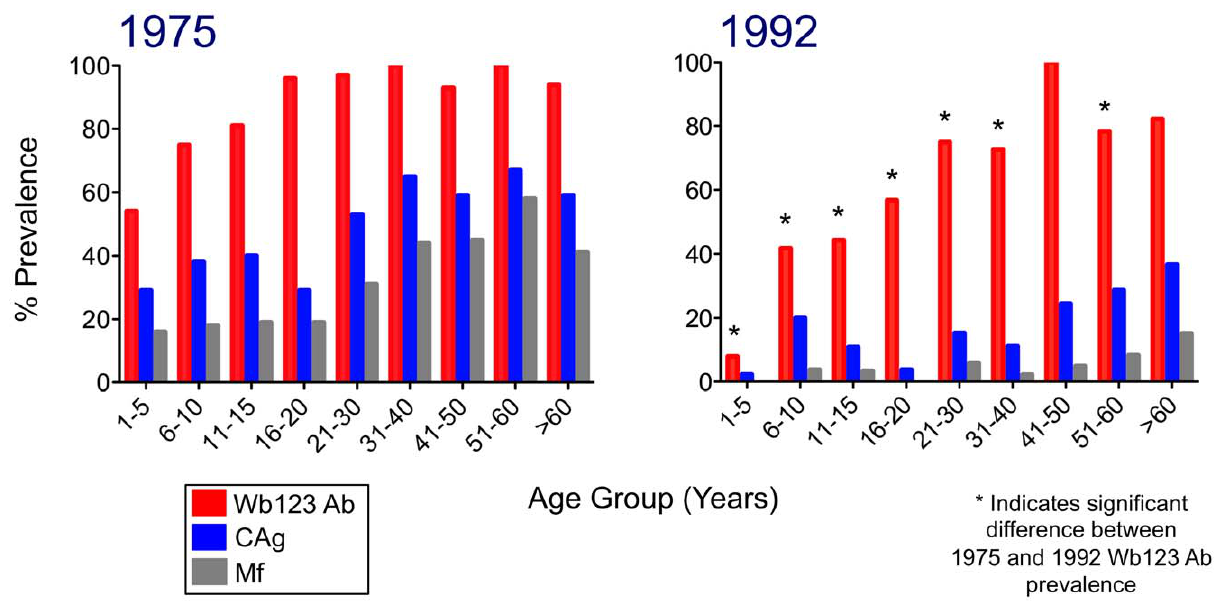
Figure 1. Prevalences of Ab to Wb123, CAg, and Mf in 1975 and 1992. Percent prevalence (y-axis) of microfilaremia (Mf; grey bars), circulating antigen (CAg; blue bars), and Ab to Wb123 (red bars) by age group (x-axis) for the study population on Mauke in 1975 (left panel) and 1992 (right panel). Asterisks represent a significant difference (p # 0.004; Fisher’s exact test) between Wb123 Ab prevelances in 1975 and 1992 within a given age